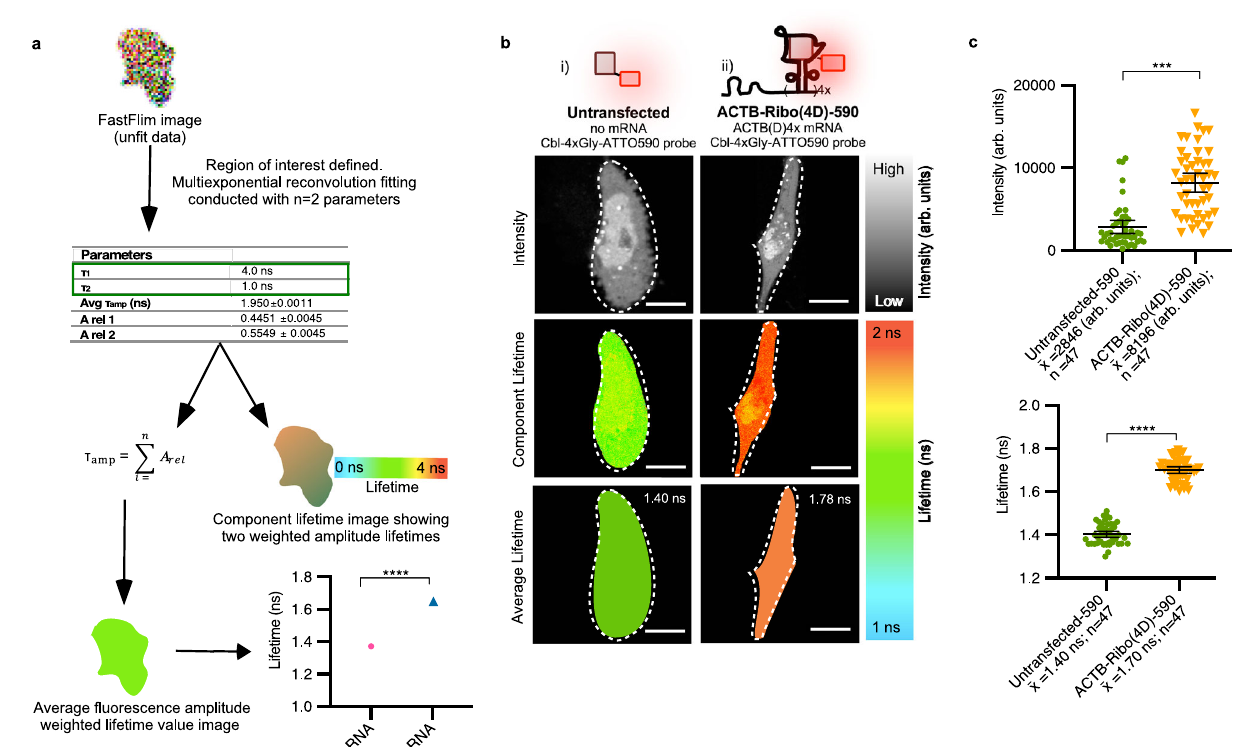
Fig. 2 | Principle of FLIM data processing. a Work fl ow to analyze fl uorescence lifetimeimagesbymultiexponentialreconvolution fi tting.Livemammaliancellsare transfectedwiththeRiboglowreporter,atransfectionmarker,andloadedwiththe Riboglow probe. Time-Correlated Single Photon Counting (TCSPC) is used to acquireaFastFlimimageusingSymPhoTime64(Picoquant)foraspeci fi cregionof interest (ROI) in live mammalian cells, resulting in the un fi t raw lifetimes of each individualpixel.Thisdatathenundergoesamultiexponentialreconvolution fi tting, producing representative quantitative data such as lifetime values ( τ 1 and τ 2 ) for furtherprocessing.Theaverage fl uorescenceweightedlifetimevaluerepresentsan average value for the entire ROI where each ROI is de fi ned as an entire cell. This analysis is used for dot plots throughout this study. Alternatively, the component lifetime image yields the lifetime value on a pixel-by-pixel basis, useful for image